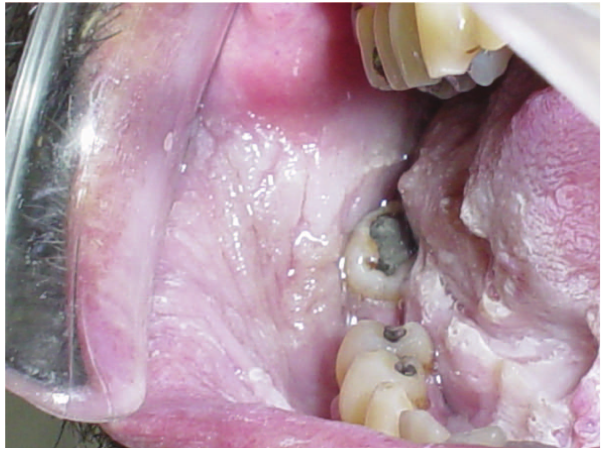
Figure 2 - Widespread white patch on buccal mucosae and floor of the mouth.